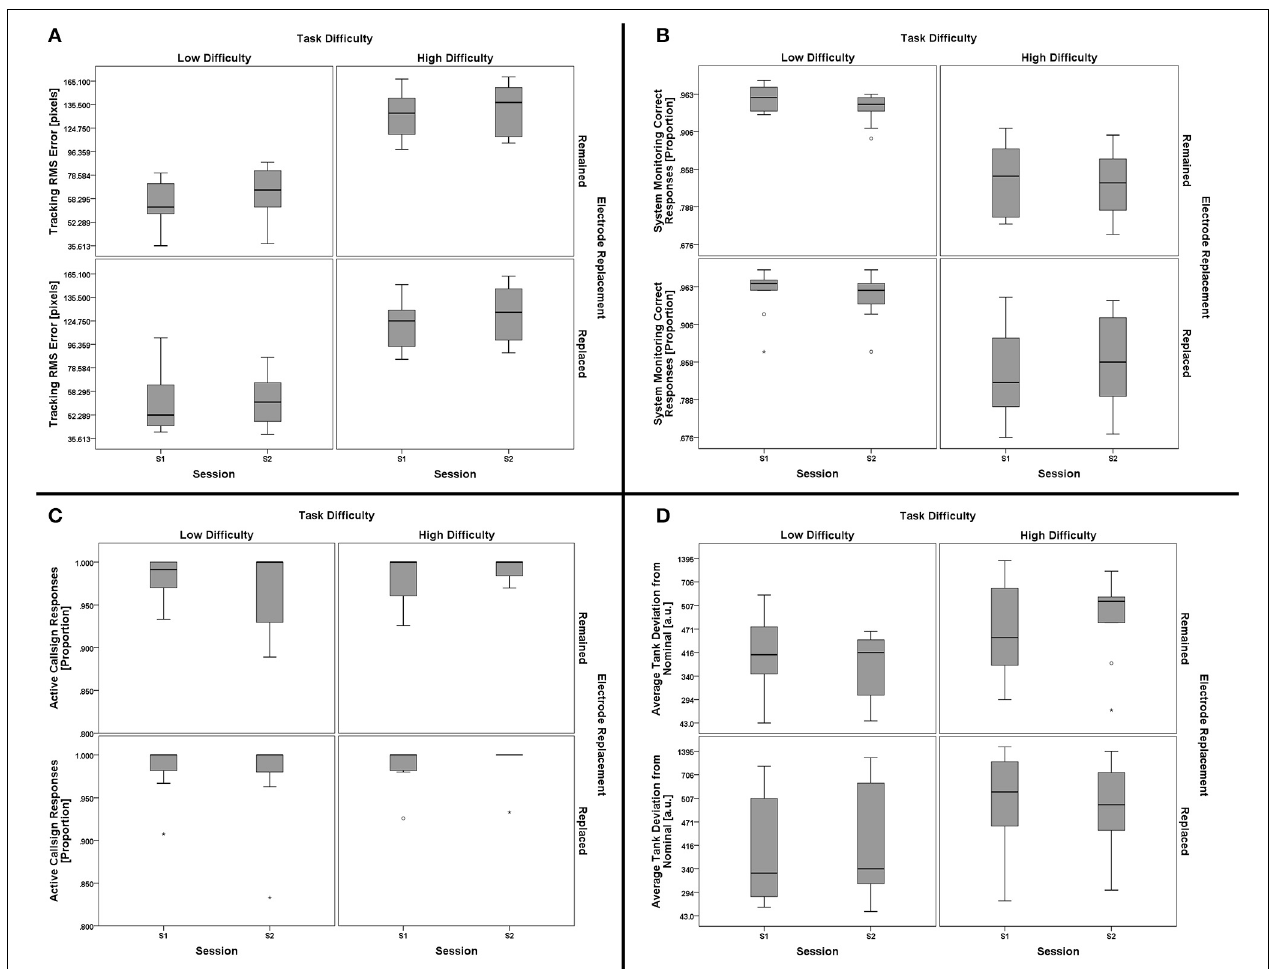
FIGURE 8 | Boxplots showing AF-MATB subtask performance data representative of the 2 (task difficulty, within) × 2 (session, within) × 2 (electrode replacement, between) mixed model MANOVA results. Individual subtask performance measures are shown for the Tracking (A) , System Monitoring (B) , Communications (C) , and Resource Management (D) subtasks. The only significant effect from all main effect and interaction tests was a main effect of task difficulty on AF-MATB performance. Subtask factors contributing to the main effect of task difficulty on AF-MATB performance were not subjected to further analysis given the goals of this work, but it is clear from the boxplot data that Tracking (A) and System Monitoring (B) task performances were affected by task difficulty. There appears to be some effect of task difficulty on the